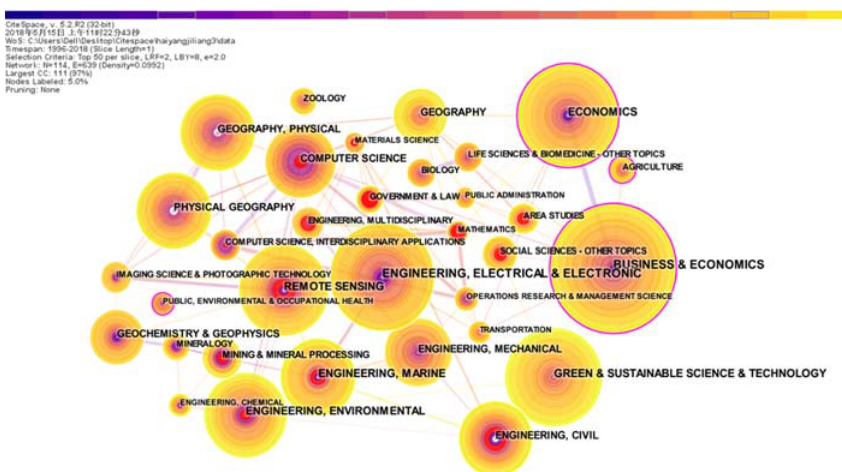
Table I. The twelve keywords with the highest frequency that appeared in marine econometrics studies